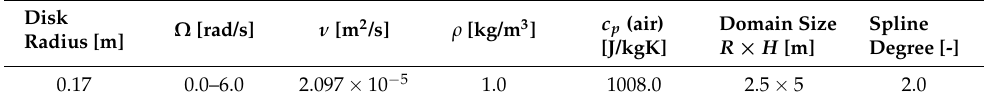
Table 5. Parameters used for the AFPM